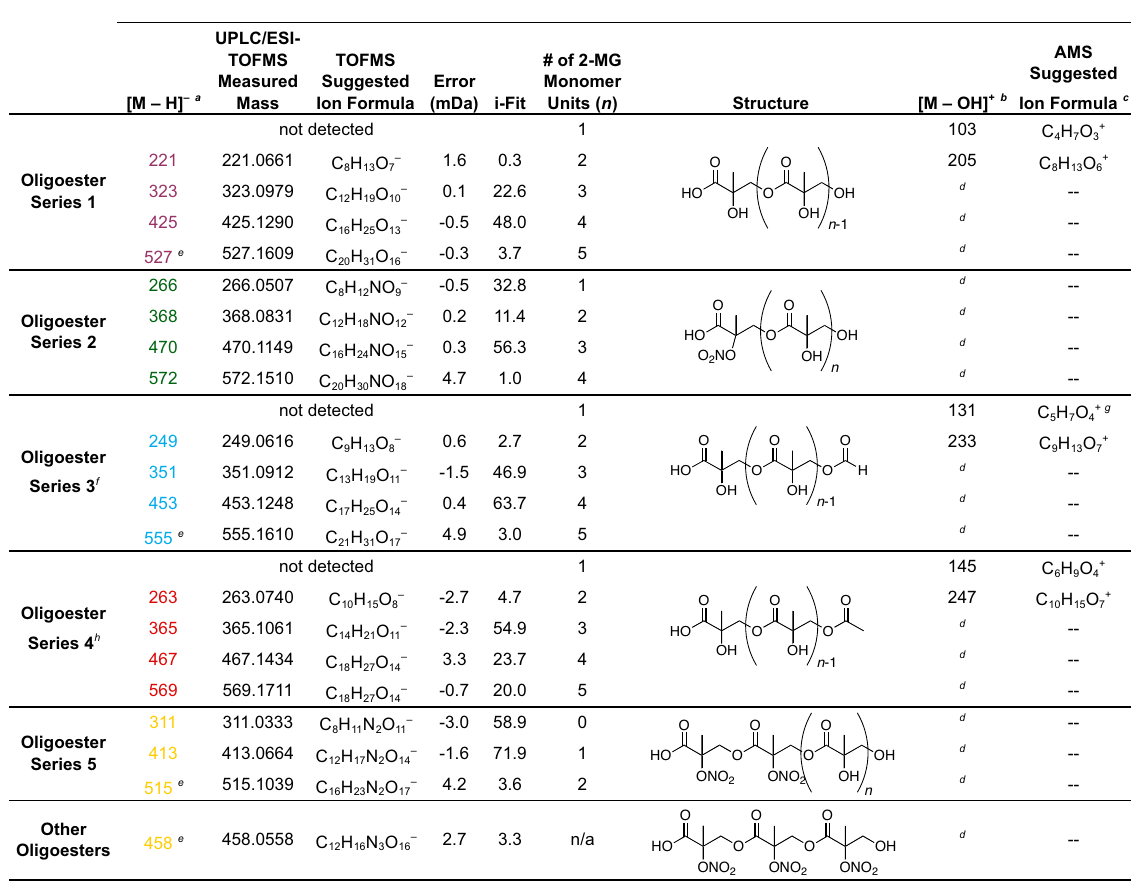
Table 3. SOA constituents detected by UPLC/( − )ESI-TOFMS and AMS in methacrolein experiments. All ions were detected in both high-NO and high-NO 2 experiments, unless otherwise